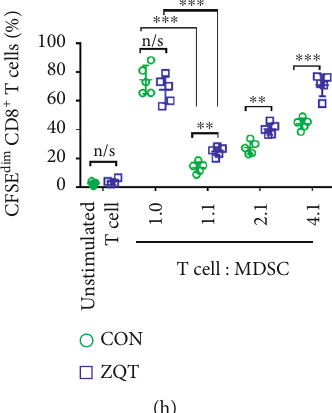
Figure 4: ZQT attenuated the immunosuppressive e ff ect of MDSCs on T cells in the tumor microenvironment. (a, b) CD3 + T cells isolated from the tumor tissue of tumor-bearing C57BL/6 mice treated with normal saline or ZQT were cocultured with LLC cells for 4 h before incubating with CD3, CD8, and CD107 α antibodies. Events shown were fi nally gated on CD3 and CD8. (c) ELISA analysis for the expression of IFN- γ in cells from the tumor tissue. (d, e) RT-qPCR quantitative analysis of Granzyme B, Perforin 1, Arg-1, iNOS, and S100A9 gene expression. (f) ROS assay for ROS production in tumor tissue from ZQT-treated mice or normal saline-treated mice. (g, h) T-lymphocyte in the spleen of wild-type C57BL/6 mice and MDSCs in tumor tissue of tumor-bearing mice treated with normal saline or ZQT were isolated using the MojoSort Mouse Isolation Kit. T-lymphocyte proliferation assay was used to show dose-dependent suppression of T cell proliferation by MDSCs isolated from tumor tissue of tumor-bearing mice treated with normal saline or with ZQT. CD3 + T cells isolated from tumor tissue stained with 5 μ M CFSE were incubated with MDSCs for 72h. Meanwhile, CD3 and CD28 antibodies were added for CD3 + T cell stimulation. Flow cytometry analysis was performed to quantify 72h CFSE dilution. n = 7 . Data are expressed as the mean ± SD . n/s: nonstatistical signi fi cance. ∗ p < 0 : 05 ; ∗∗ p < 0 : 01 ; ∗∗∗ p < 0 : 001